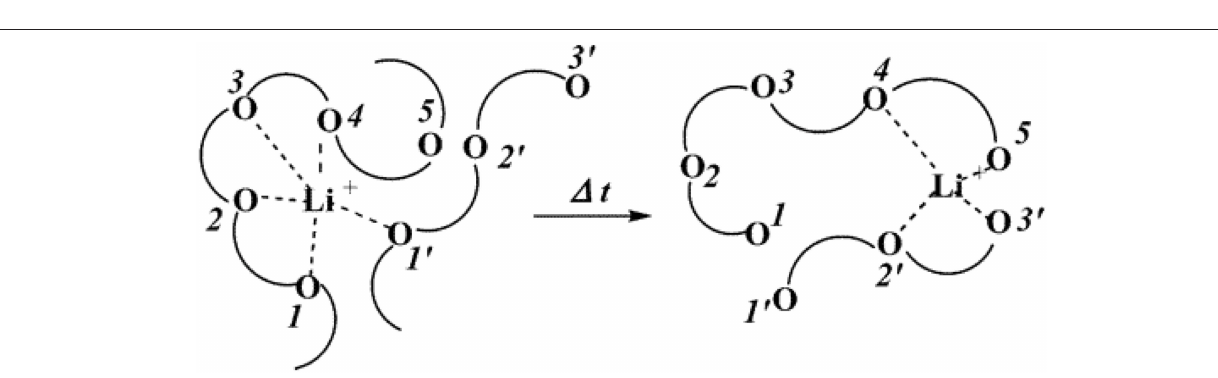
FIGURE 3 | Schematic diagram of lithium ion conduction mechanism of PEO-based polymer electrolyte. [Reproduction with permission from Xu (2004), Copyright 2004, American Chemical